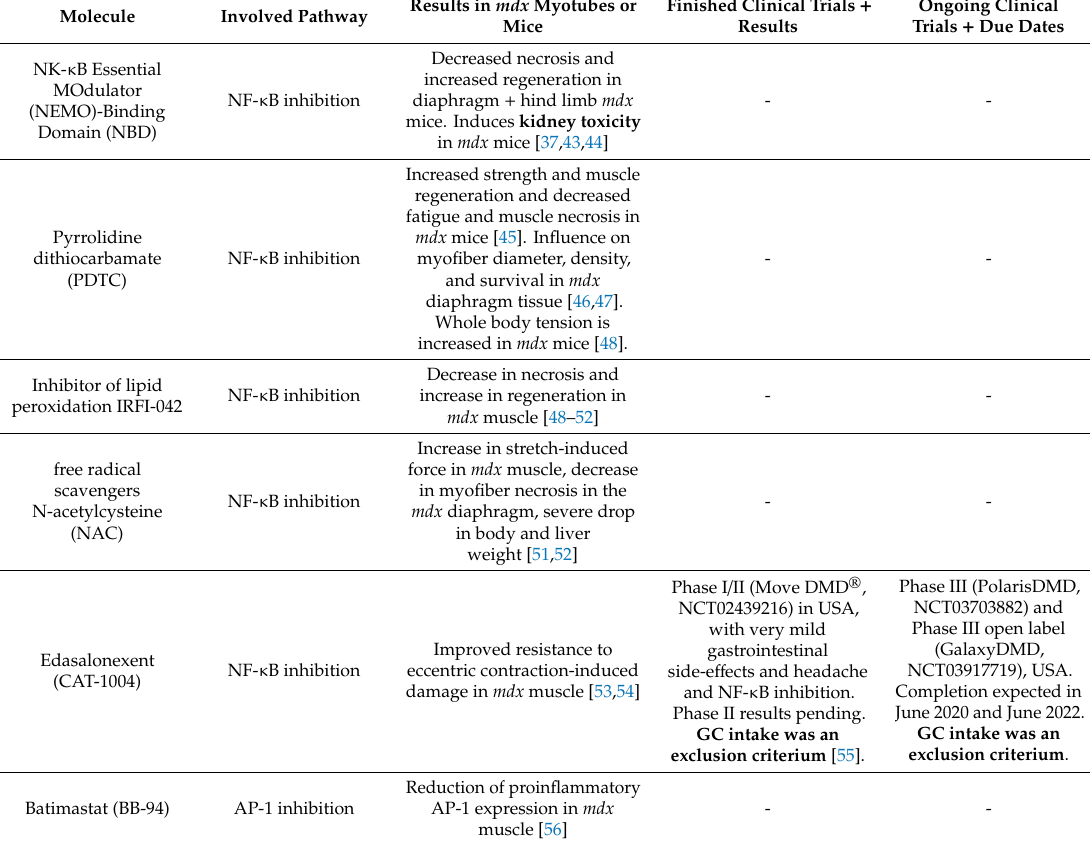
Table 3. Overview of nuclear factor kappa-light-chain-enhancer of activated B cells (NF- κ B) and finished clinical trials and results, ongoing clinical trials and due dates, and putative